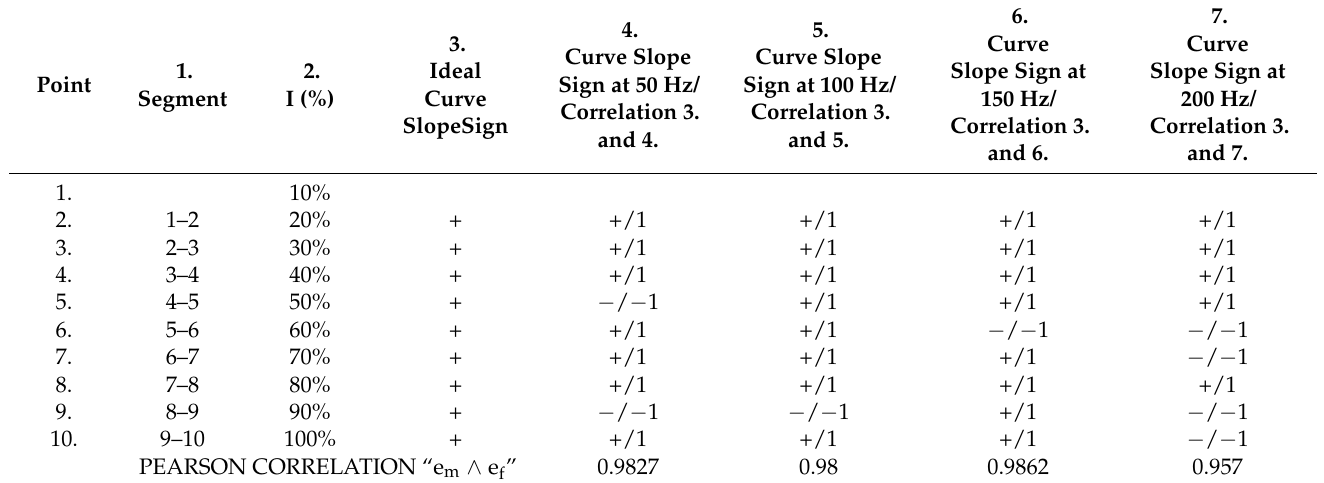
Table 4. Correlation of ideal curve segments and measured curve